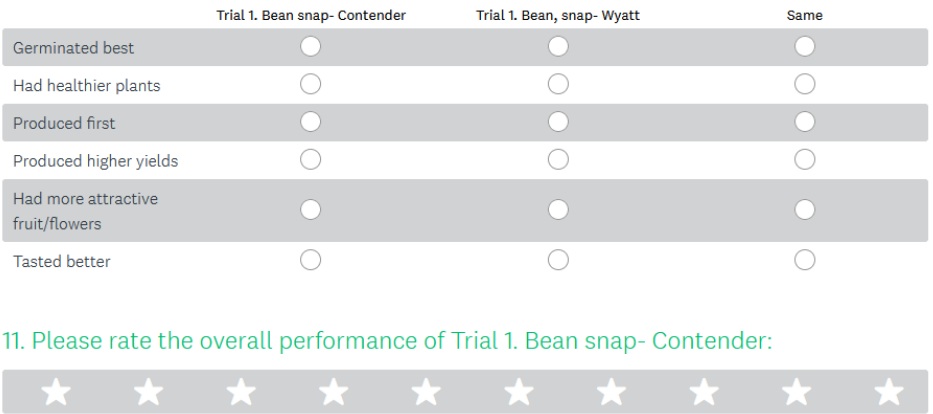
Figure 1. Example question block from online evaluation form illustrating the comparison of the performance of the two trial cultivars in the 2021 snap bean trial.